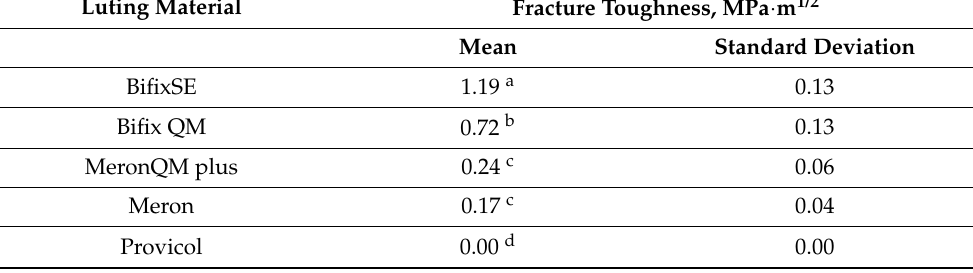
Table 3. Fracture toughness arranged in descending order. Superscript characters indicate statistically homogeneous subgroups within a column; Tukey’s honestly significant difference (HSD) test, α = 0.05.